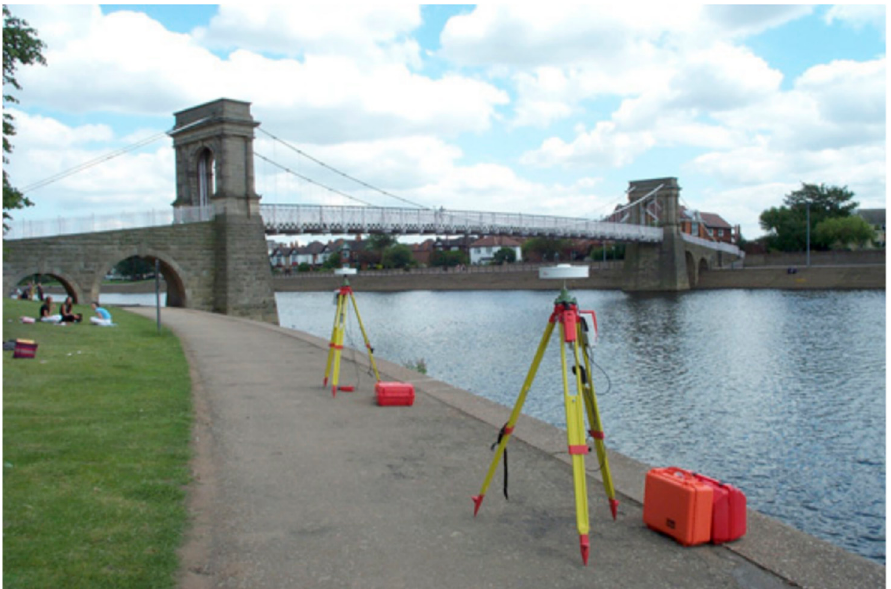
Figure 8. Wilford Bridge, Nottingham, UK.